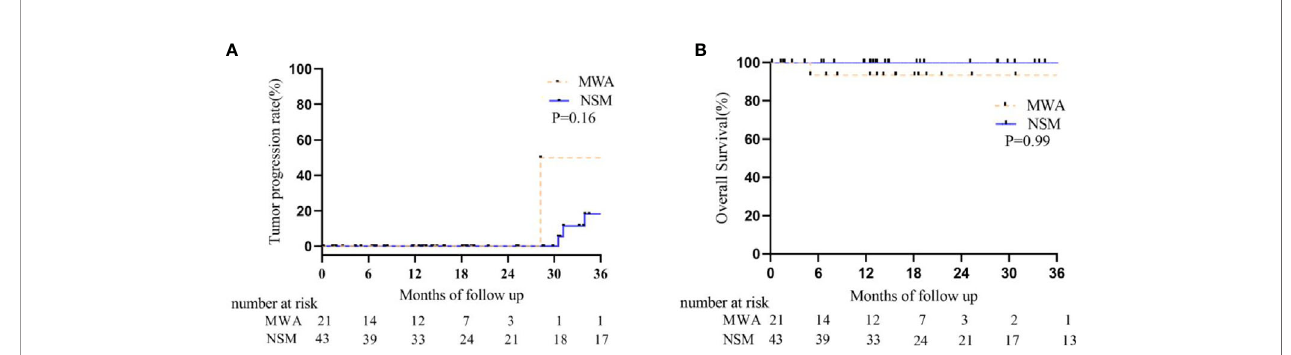
FIGURE 3 | Kaplan – Meier estimates for tumor progression and survival between BC patients who underwent MWA and NSM. (A) Tumor progression rate. The 1-, 2-, and 3-year intra- and extra-breast recurrence rate were 0, 0, 50% in the MWA group and 0, 0, 18.3% in the NSM group, respectively (P = 0.08). (B) Cumulative overall survival rate. The 1-, 2-, and 3-year overall survival rate were 93.3, 93.3, 93.3% in the MWA group and 100, 100, 100% in the NSM group, respectively (P = 0.99).